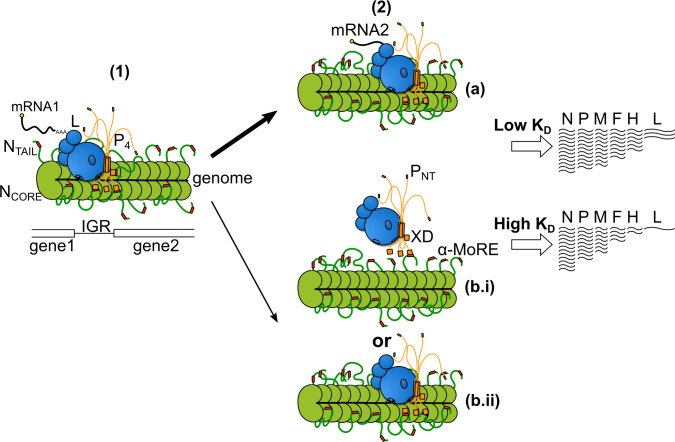
Model of transcription re-initiation.(1) The polymerase complex, composed of L and P proteins, transcribes the genome. (2) After addition of the poly(A) tail and release of the mRNA, the polymerase complex may re-initiate transcription and transcribe the next gene (a) or stop transcribing (b). Whether the polymerase complex detaches from the genome template (b.i) or travels on it until reaching the 5’ end of the genome (b.ii) remains to be determined. The higher is the KD, the less efficient is the re-initiation of transcription, thus leading to a steeper mRNA gradient.